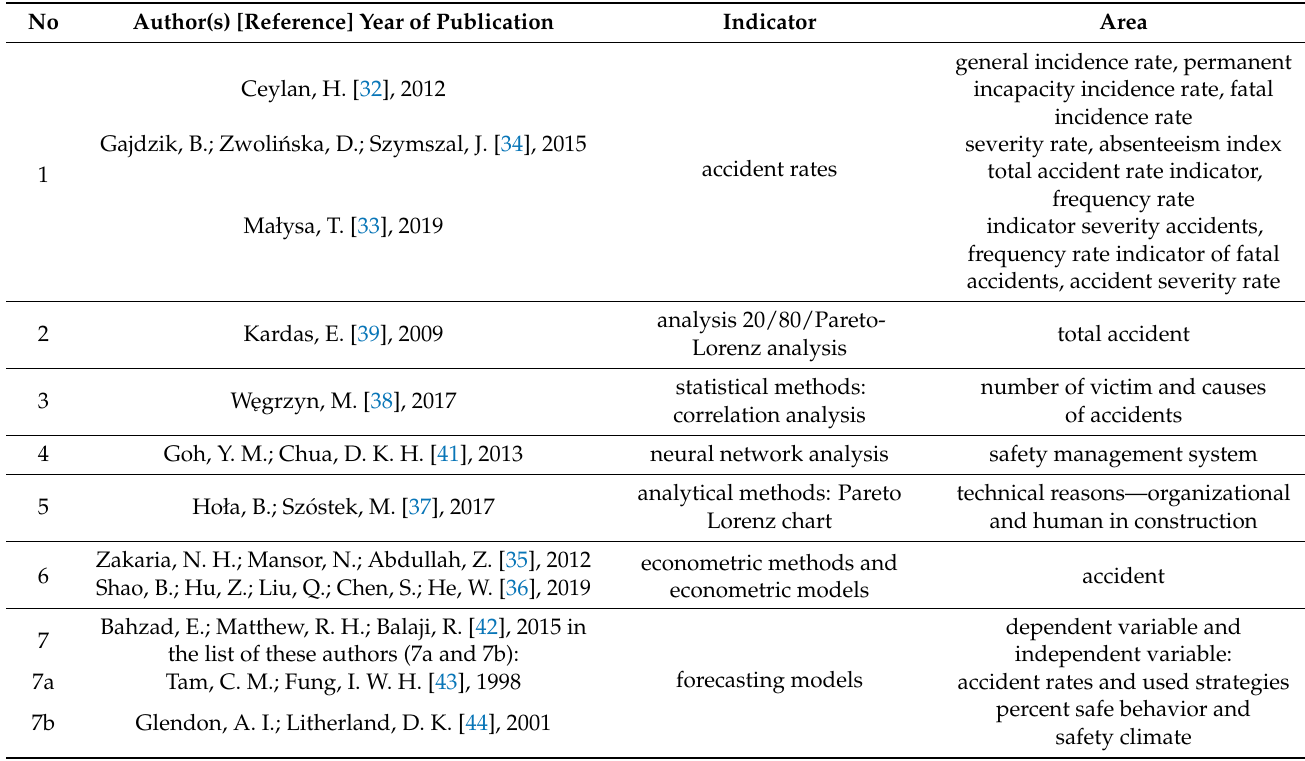
Table 1. A collective summary of research in the field of occupational safety presented in the literature (own